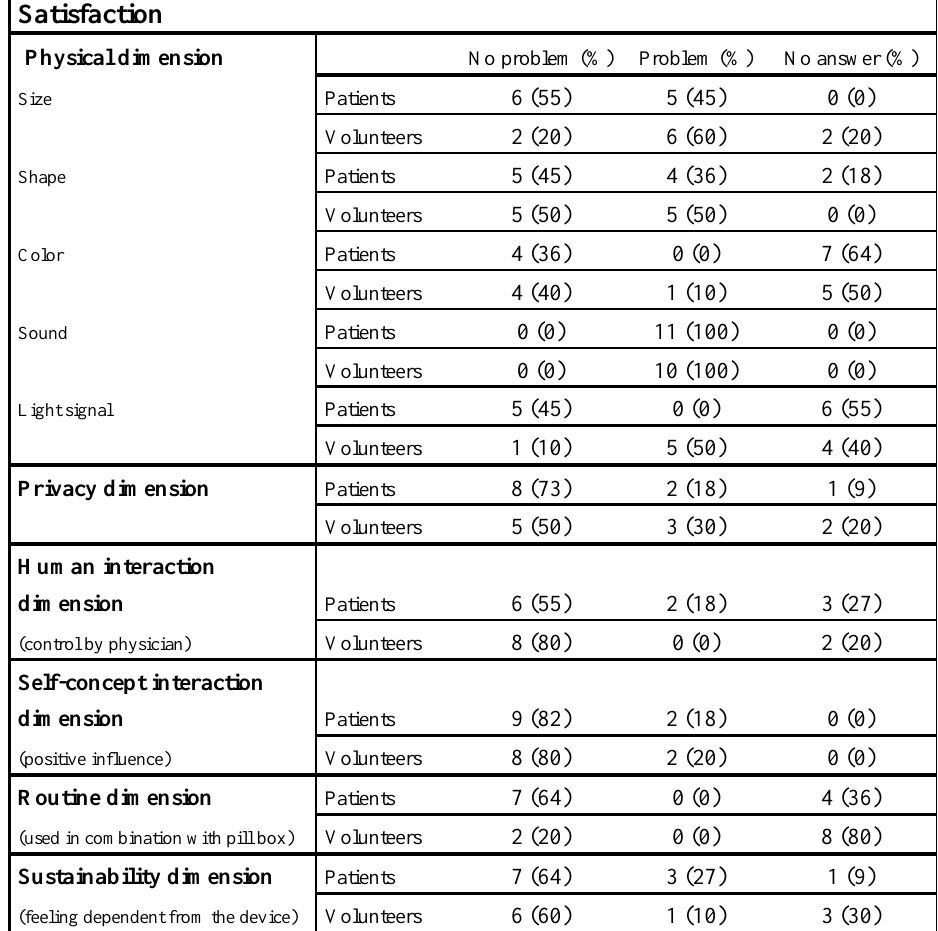
Table 5. Results on satisfaction of the Helping Hand™ (patients: n = 11, volunteers: n = 10).